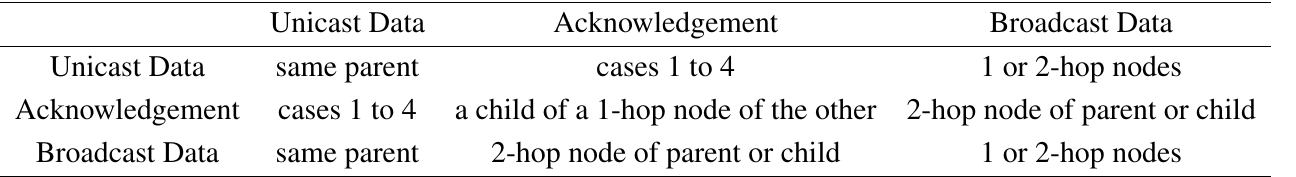
Table 2. Possible collisions in case of data gathering application, broadcast and immediate